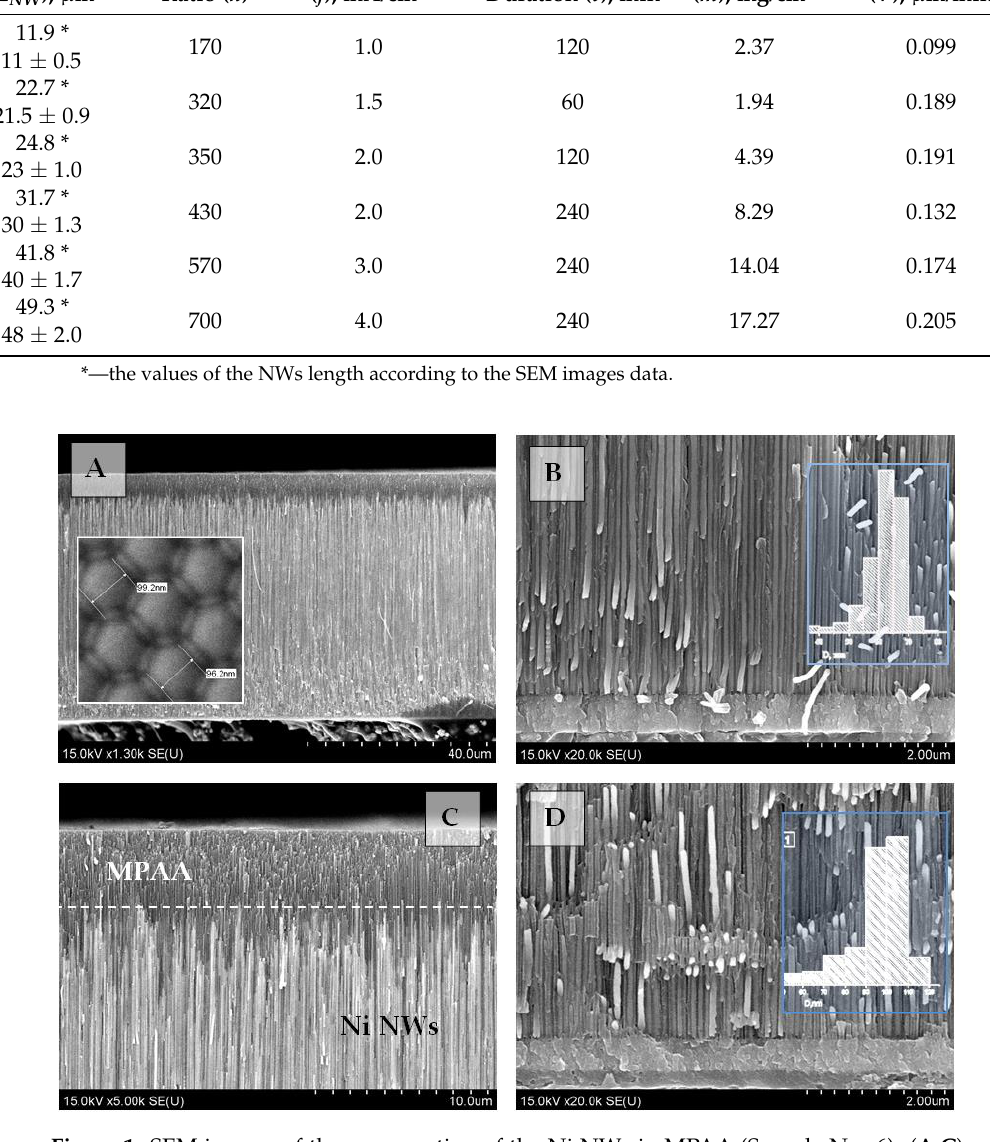
Figure 1. SEM images of the cross-section of the Ni NWs in MPAA (Sample No. 6): ( A , C )—near the MPAA surface; ( B , D )—near the bottom of the MPAA. The insets show the SEM images of the MPAA bottom (hexagonally packed oxide cells and their size) ( A ) and histograms of the diameter distribution ( B ) and the distance between NWs ( D ).